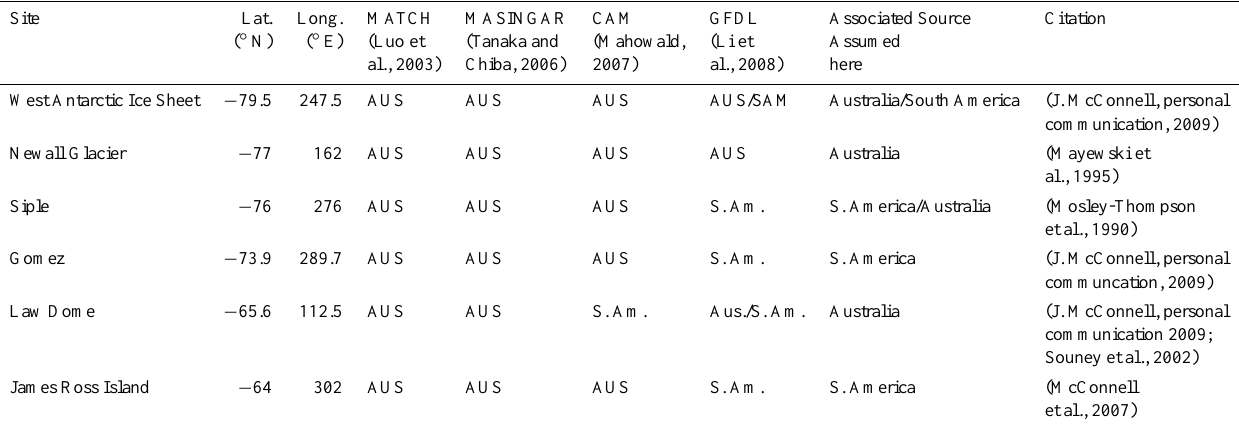
Table 3. The location of the paleodata sites and associated source used to infer the 20th century dust trends for the Antarctic cores. The source provenance from different model studies is also given. Site Lat. Long. MATCH MASINGAR CAM GFDL Associated Source Citation ( ◦ N) ( ◦ E) (Luo et (Tanaka and (Mahowald, (Li et Assumed al., 2003) Chiba, 2006) al.,